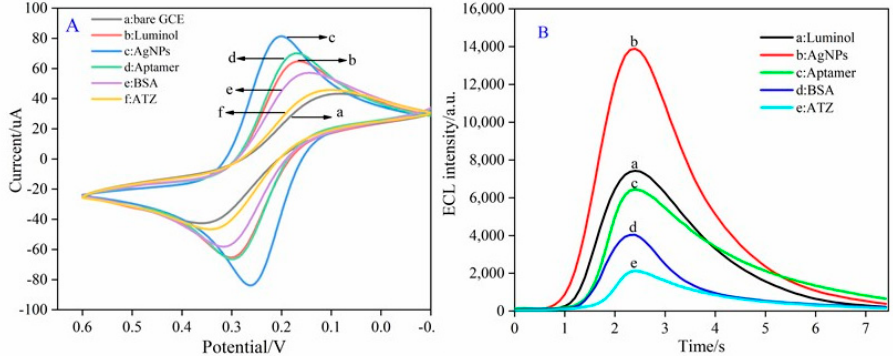
Figure 2. (A) CV property of the fabricated electrodes. (B) ECL property of the fabricated